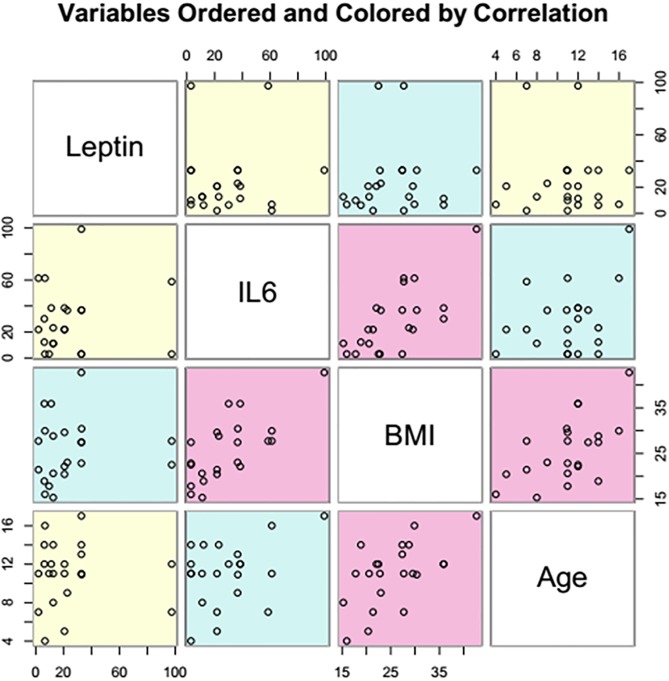
Correlation of the variables: Leptin, IL-6, BMI and age in case of children selected for the study (pink—Strong correlation, blue—Weak correlation, yellow—No correlation).